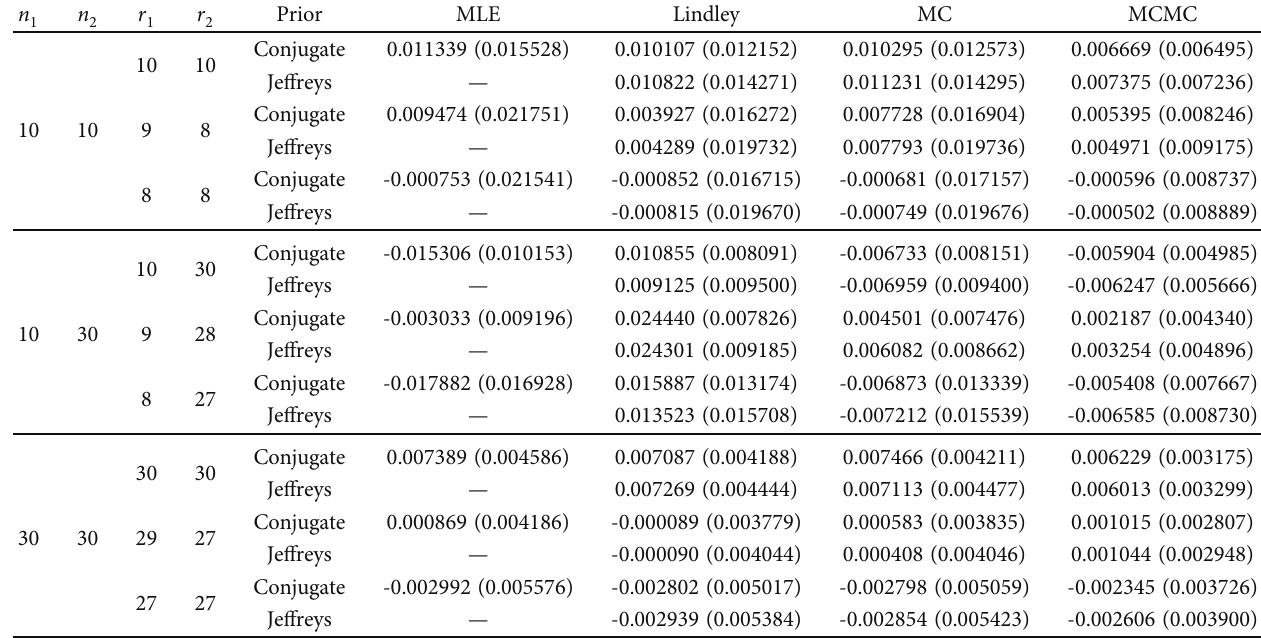
= 1, β = 1, γ = 1, R = 1/2 1 2